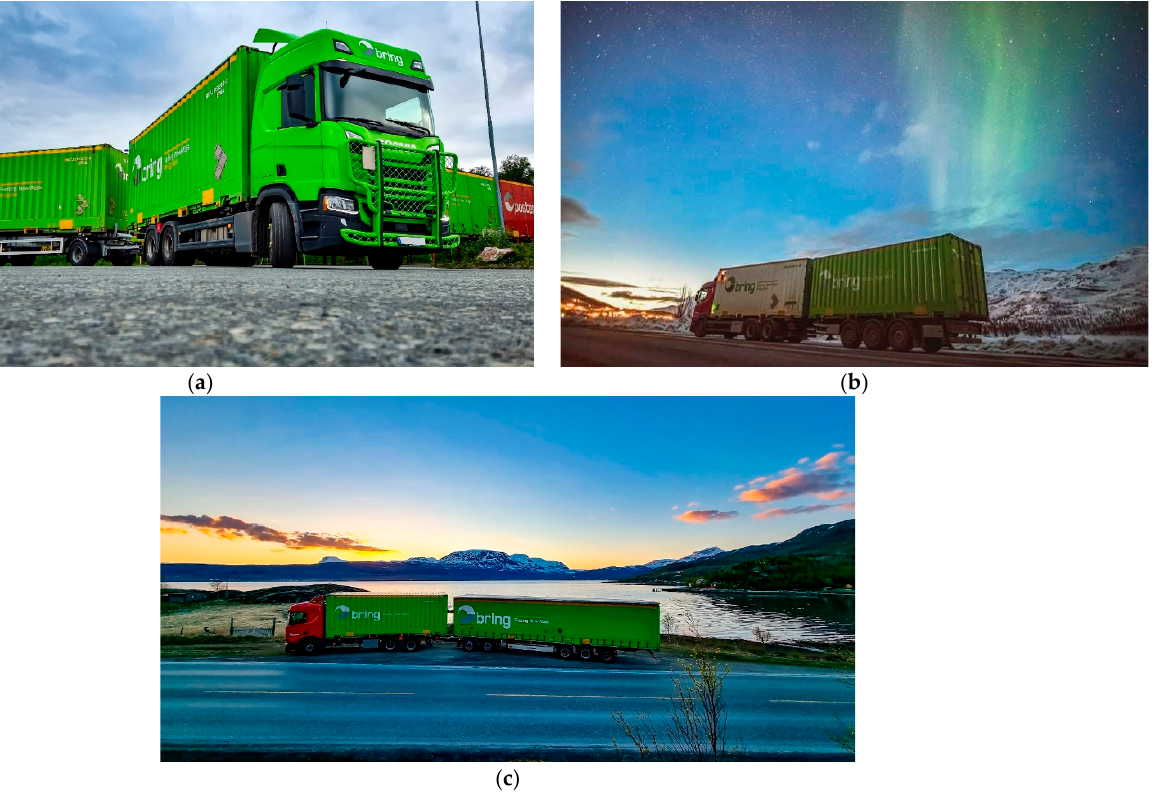
Figure 1. Truck + trailer with steered axle ( a ), truck + trailer ( b ), truck + dolly trailer + semi-trailer ( c ). Photo: Karolina Plecha.